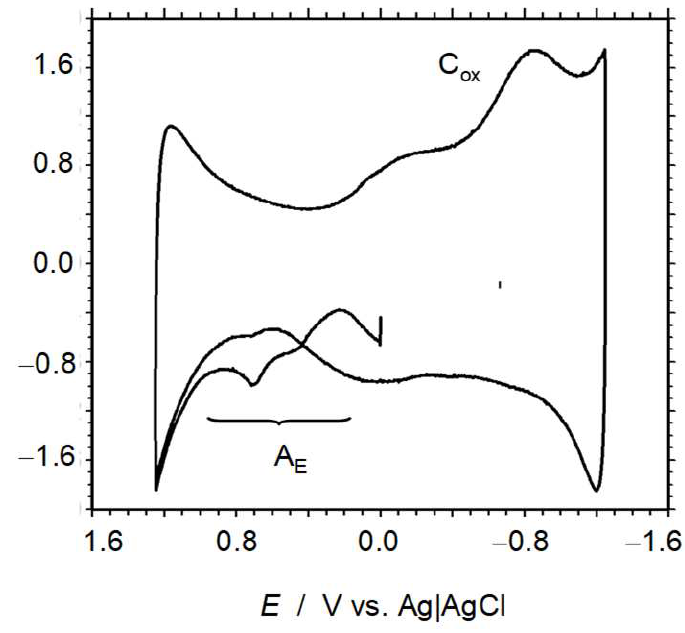
Figure 1. Cyclic voltammogram after semi-derivative convolution of a microparticulate deposit of the ethanolic extract of sample A − 5 on GCE in contact with air-saturated 0.25 M HAc/NaAc aqueous buffer at pH 4.75. Potentials can initiate at 0.0 V vs. Ag/AgCl in the positive direction; potential scan rate 50 mV s − 1 .